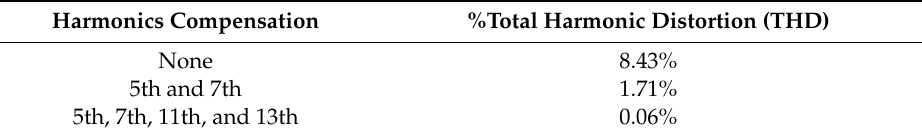
Figure 9. Current frequency spectrum. ( a ) No harmonics compensation, ( b ) 5th and 7th harmonic compensation. ( c ) 5th, 7th, 11th, and 13th harmonic compensation. Table 3. The current total harmonic distortion (THD) with and without SRF.